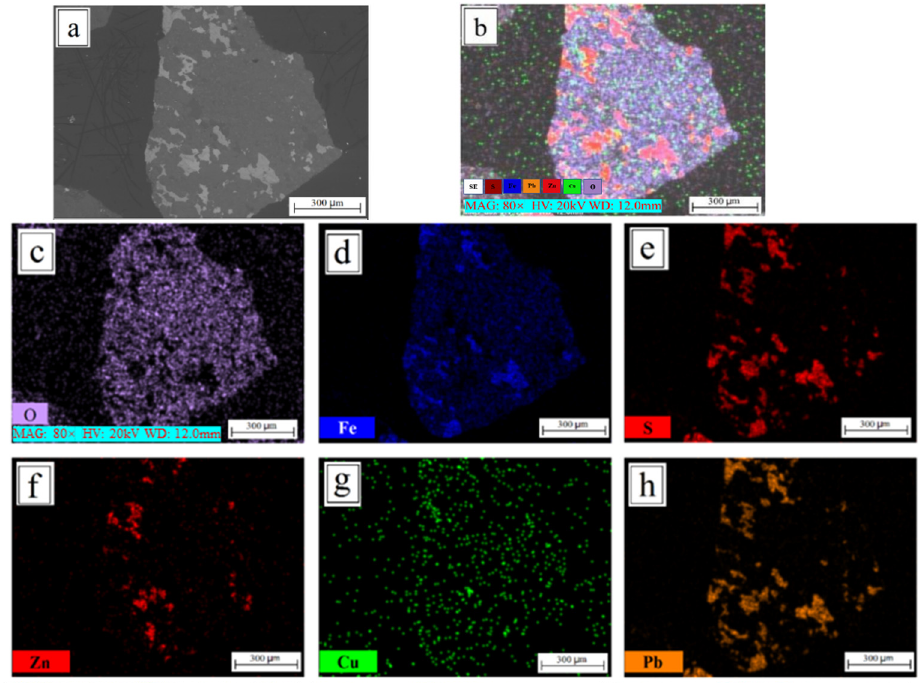
Figure 4. Surface distribution of elements in lead–zinc ore.